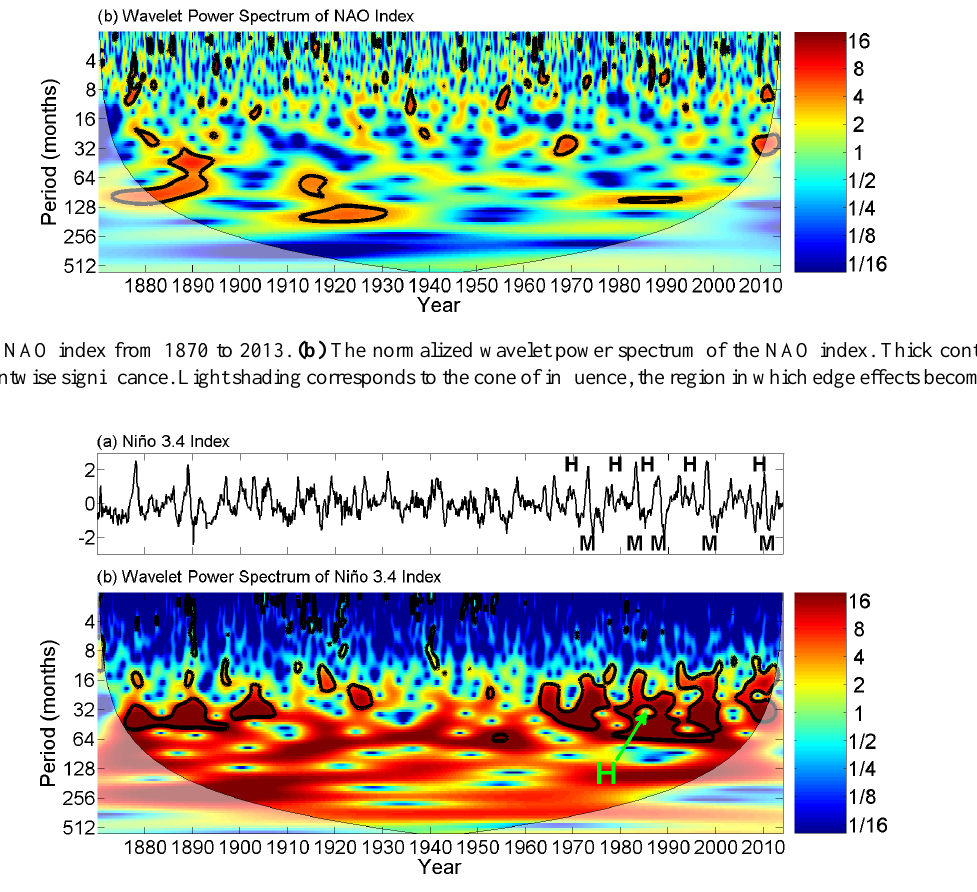
Figure 2. (a) The Niño 3.4 index time series from 1870 to 2013. Points labeled “M” indicate where the merging process occurred and points labeled “H” indicate where a hole was formed (see Sect. 5.2 for details). (b) Same as Fig. 1b except for the Niño 3.4 index for the period 1870–2013. “H”, together with the arrow, marks the location of a